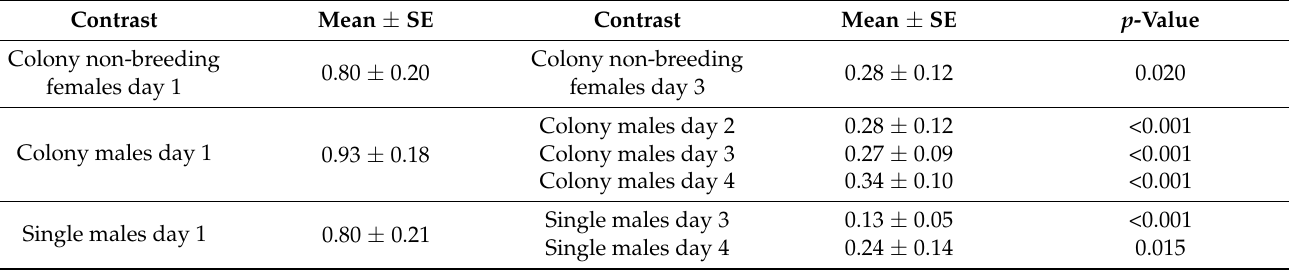
Figure 3. Mean time (±SE) taken by colony- ( A ) and single-housed ( B ) Damaraland mole-rats to complete a Y-shaped maze on four consecutive days. Significant differences between the different groups are indicated in Table 2. Table 2. Significant post hoc differences in the mean time to complete a Y-shaped maze in Experi- ment 2 between experimental day 1 and days 2, 3 and 4.